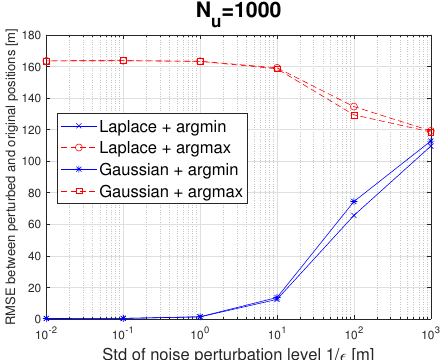
Figure 8. RMSE between the perturbed location and original location versus the noise perturbation level for two noise types (Laplacian and Gaussian) and two mapping metrics (argmin and